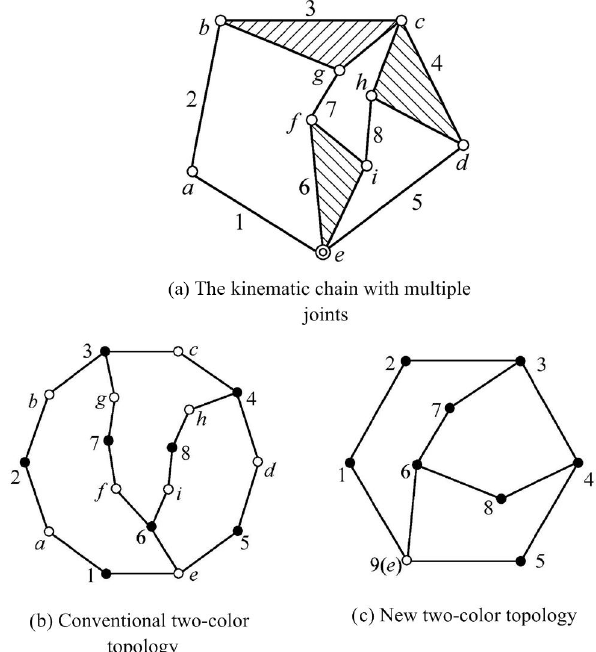
Figure 1. A kinematic chain with multiple joints and topology dia-